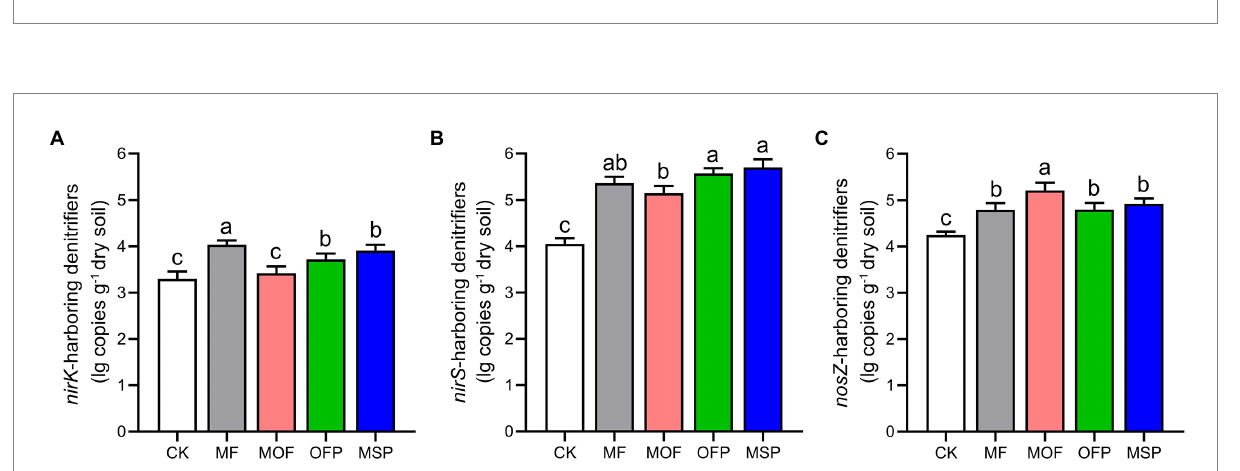
FIGURE 3 The copy numbers of nirK (A) , nirS (B) , and nosZ (C) genes under different fertilization treatments. Bars ( n = 3) with different lowercase letters indicate significant differences based on Tukey’s HSD test ( p < 0.05). CK, No fertilization; MF, mineral fertilizer; MOF, mineral fertilizer plus commercial organic fertilizer; OFP, commercial organic fertilizer; MSP, maize